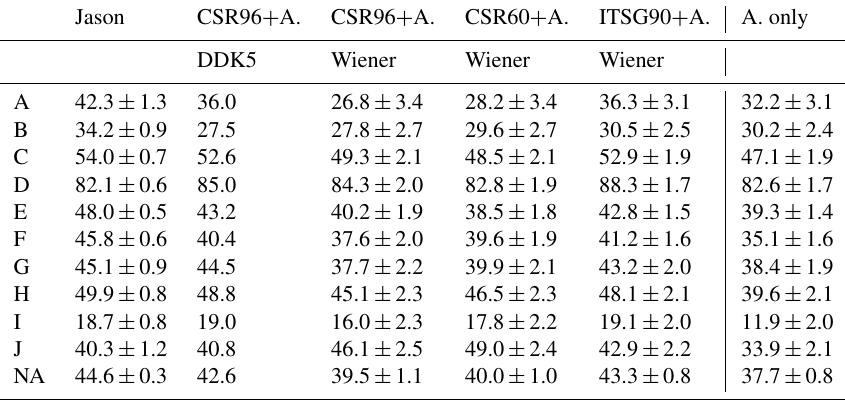
Table 5. Amplitudes (mm) of the annual signal from total sea level from altimetry and the sum of steric and mass from Argo and GRACE for different filter solutions. Jason CSR96 + A. CSR96 + A. CSR60 + A. ITSG90 + A. A. only DDK5 Wiener Wiener